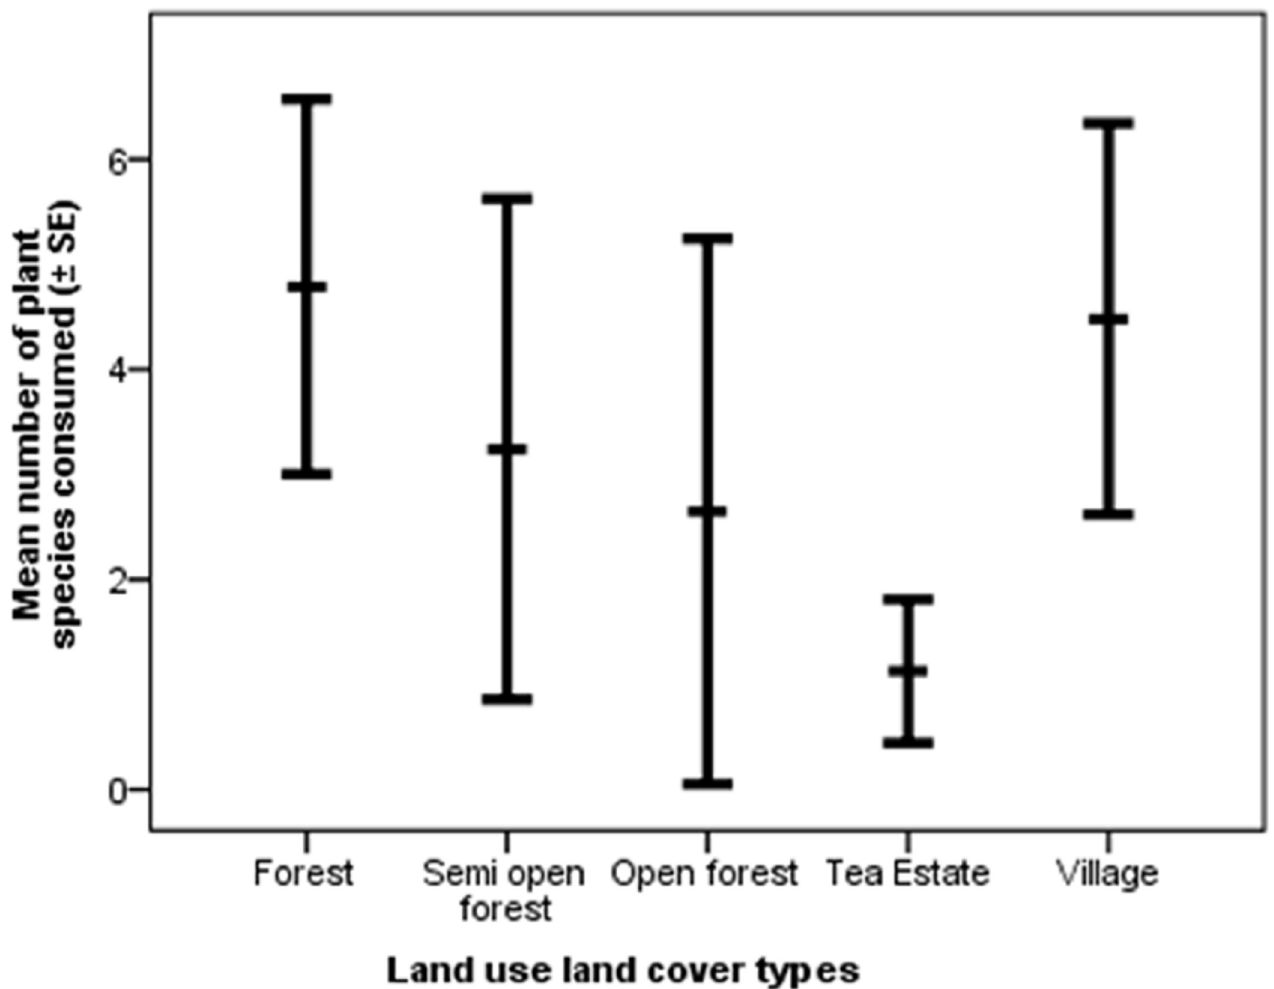
Fig 4. Mean number of plant species consumed per trail by Asian elephant.